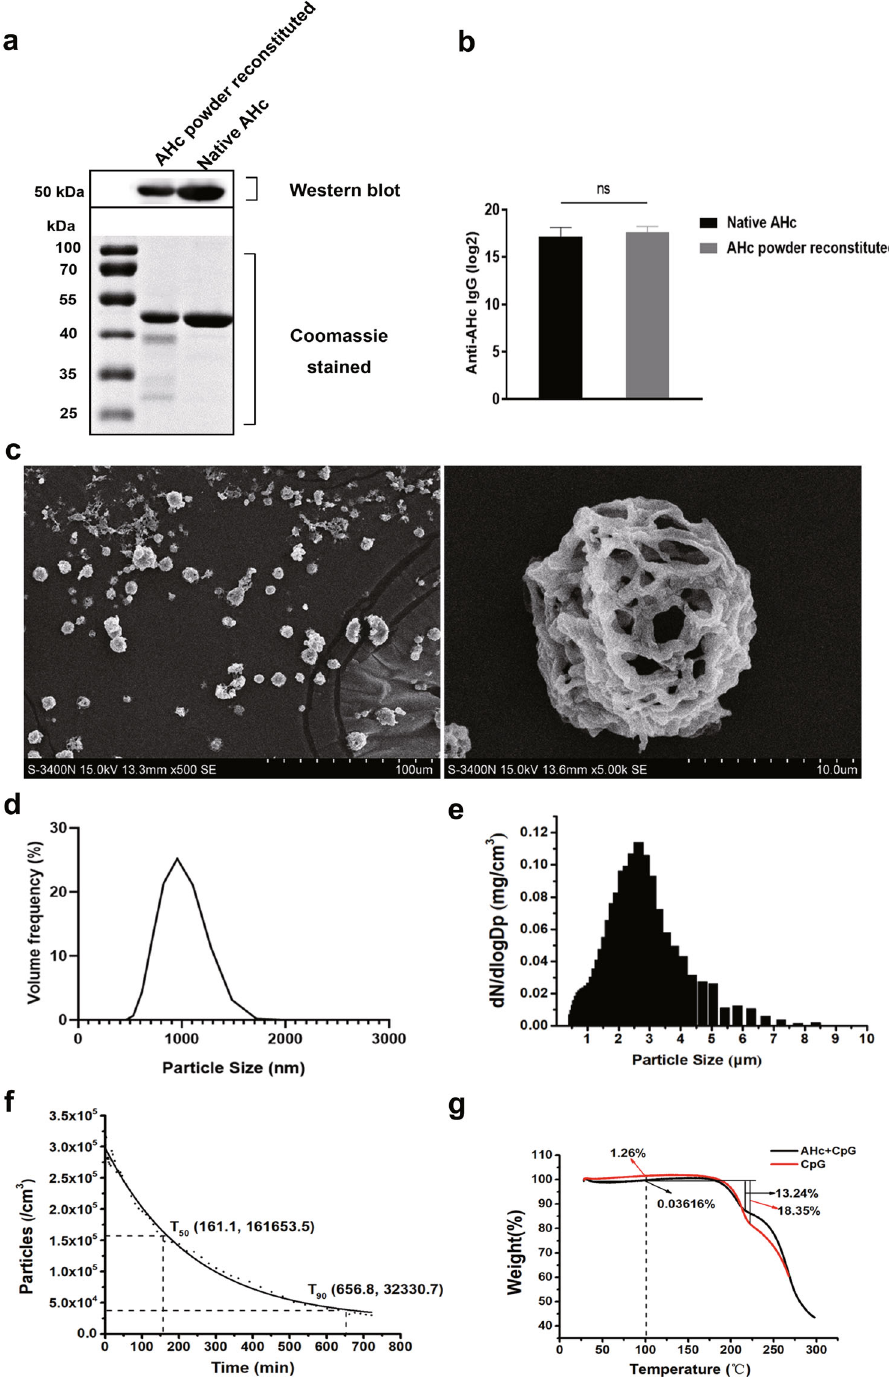
Fig. 1 Characterization of AHc dry powder. a AHc dry powder and AHc liquid were analyzed by western blot using mouse polyclonal antibodies to AHc (upper panel). A protein gel stained with Coomassie brilliant blue was used as a loading control (lower panel). b The immunogenicity of AHc dry powder and AHc liquid was analyzed by ELISA using mouse polyclonal antibodies to AHc. c Scanning electron microscopy images of AHc dry powder. d The Z-average of the mean size of the AHc dry powder, as determined using a Malvern Zetasizer Nano S90. e The MMAD of AHc aerosol dry powder, as measured using a TSI Model 3321 Aerodynamic Particle Sizer (APS) aerosol spectrometer (TSI APS spectrometer 3321). f Sedimentation of AHc dry powder, as measured using a TSI APS spectrometer 3321. g TGA of the AHc dry powder and CpG dry power The survivors from all groups began to gain weight after day 4 died within 4 days (Fig. 4e, f), and two mice of the i.t.-AHc postchallenge (Supplementary Fig. 4b). The survival percentage of (powder)-immunized group, one mouse of the i.t.-AHc (liquid)- the i.t.-AHc (powder reconstituted)-immunized group was slightly immunized group, and one mouse of the i.t.-AHc (powder higher than that of the s.c.-AHc (powder reconstituted)-immunized reconstituted)-immunized group died within 4 days (Fig. 4d – f).